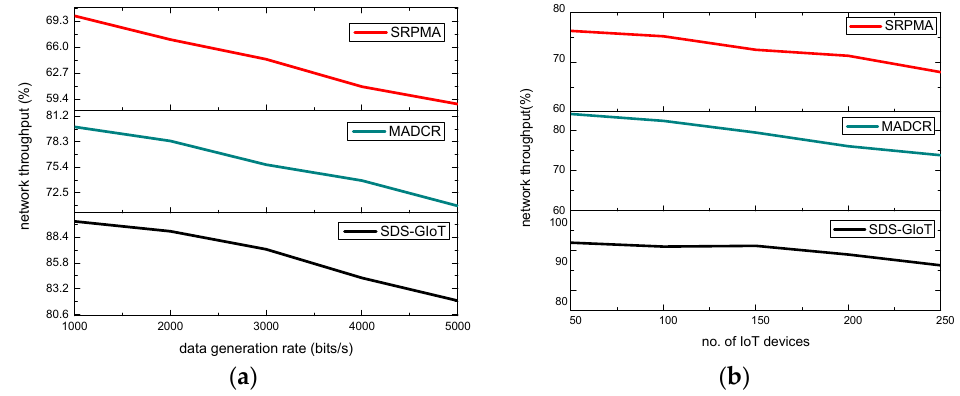
Figure 4. Scenarios for varying IoT devices and data generation rates in terms of network throughput. ( a ) network throughput and IoT devices. ( b ) network throughput and data generation rates.